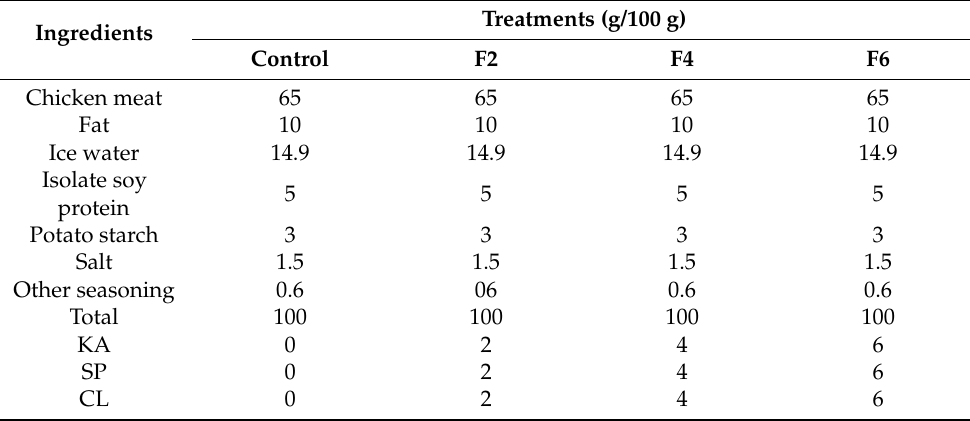
Table 2. Chicken sausage